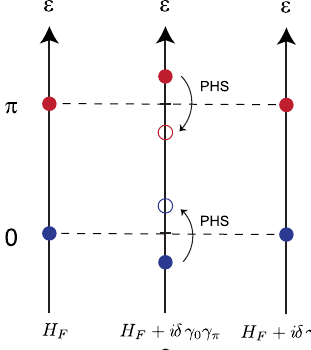
FIG. 2. Schematic picture of quasienergy spectrum of non- interacting fermionic Floquet SPTs. The particle-hole symmetry of BdG equations indicates that a bilinear coupling between a MZM and a MPM is ineffective and cannot move the MZM or MPM away from 0 or π quasienergy, respectively. The leftmost line shows the unperturbed quasienergies. The middle line illustrates that any possible splitting due to the perturbation does not respect particle-hole symmetry (PHS), indicating that the resulting quasienergies (rightmost line) must be identical to the initial unperturbed quasienergies 0 and π (leftmost